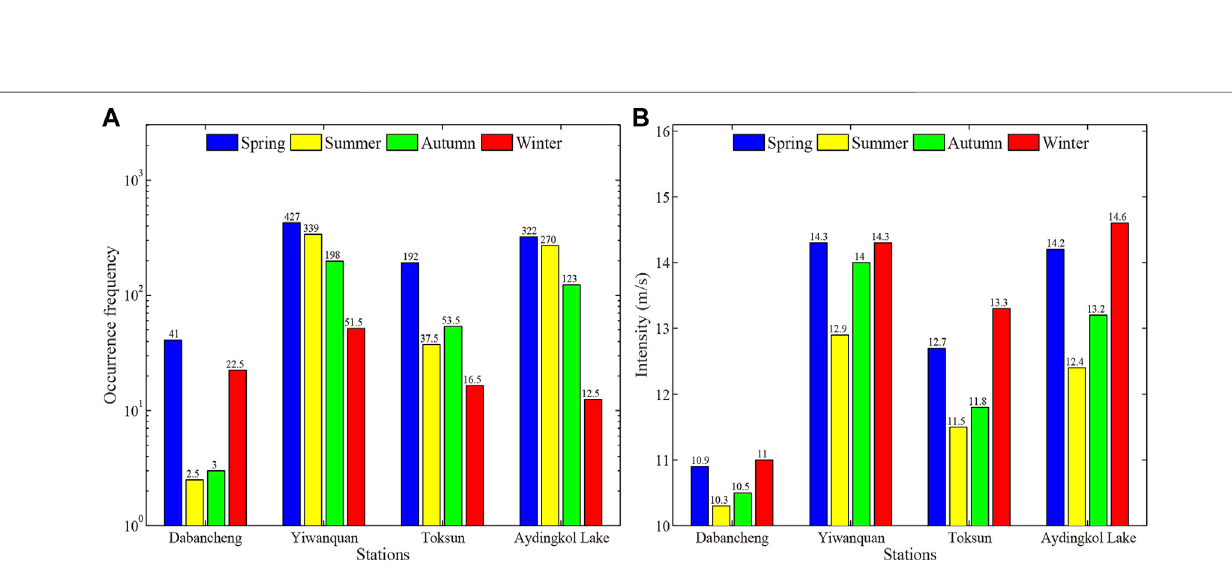
Frontiers in Earth Science |